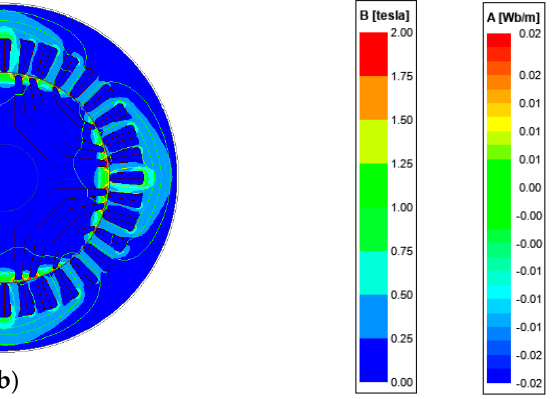
Figure 11. Measuring the inductances using the VI method.